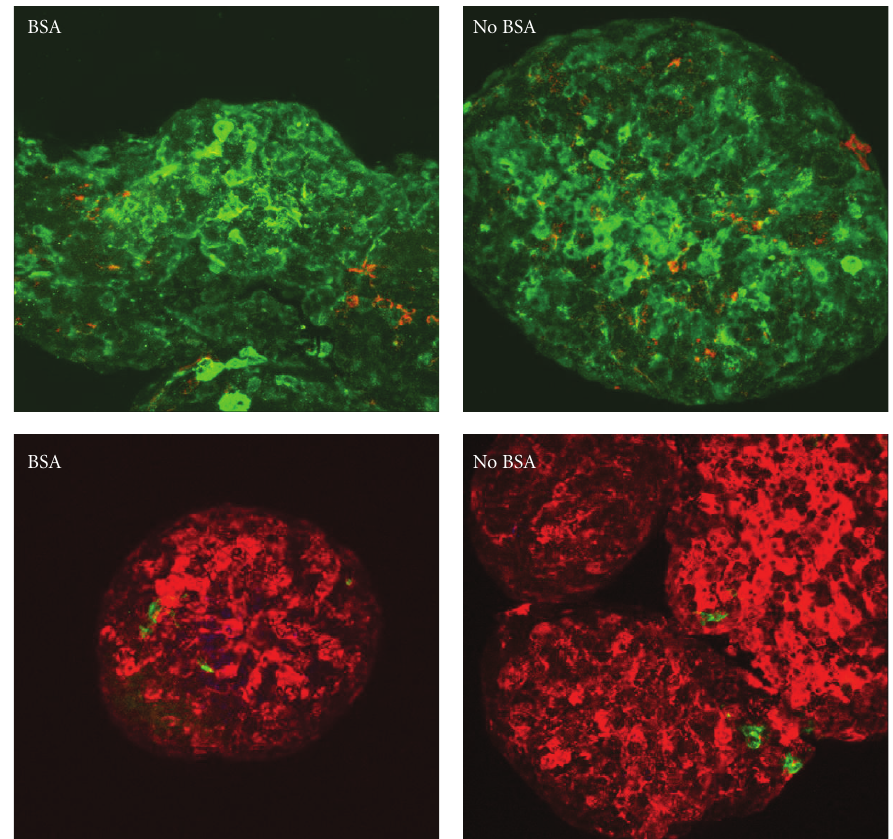
Figure 5: Left hand panels show islets isolated with BSA while right hand panels show islets isolated without BSA. The islets were fixed in 4% PFA and cyto-spun onto glass slides before staining. Islets in top panels were stained for insulin (green) and glucagon (red). Bottom panels instead show insulin stained in red while duct cells were stained in green. Original magnification